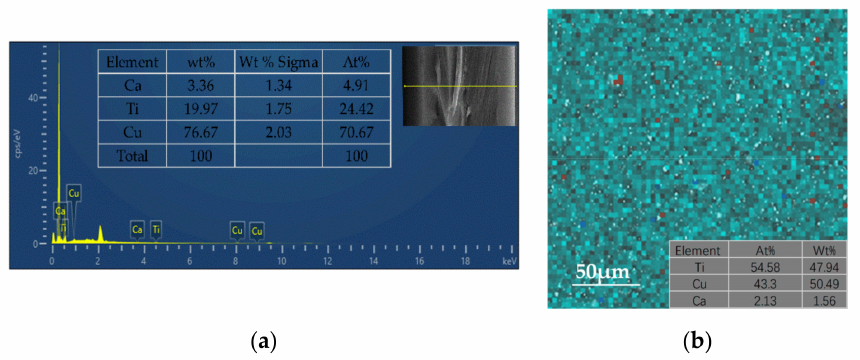
Figure 6. ( a ) The EDS image of a cross-section of a PI-(CCTO/PI)-PI nanocomposite film. Additionally, ( b ) the EDS images of the CCTO/PI nanocomposite